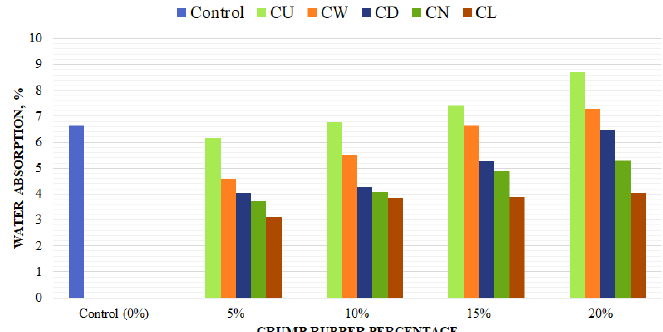
Figure 4. Water absorption at 28 days.